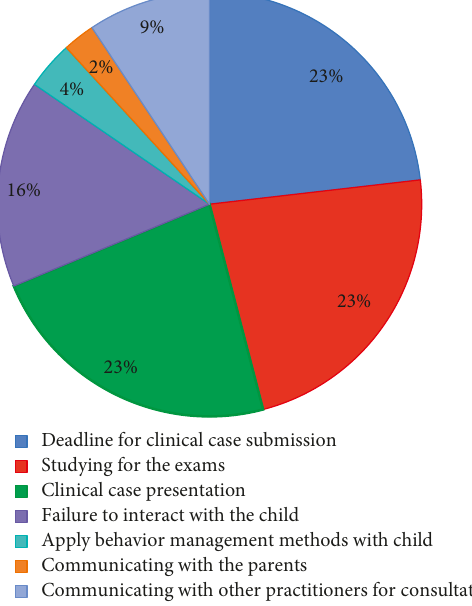
Figure 4: Level of anxiety during academic situations.